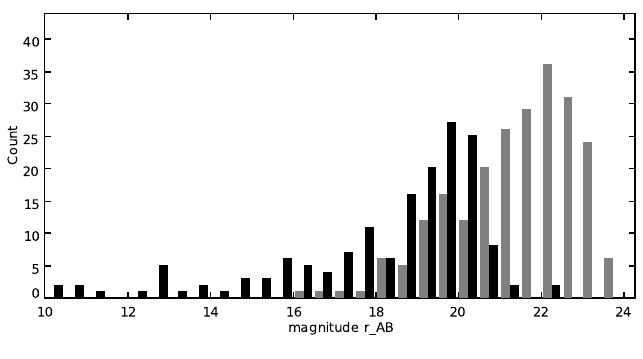
Fig. 1. The distribution of identified RCR sources with significant magnitude vari- ations (∆ m > 0 : 7 mag; black) and sources that have no such variations (grey). The comparison was carried out according to the USNO-B1, GSC 2.3 and SDSS DR7 data as well as to the 2MASS and UKIDSS LAS data. than ∆ m (cid:21) 0 : 7 mag in close optical or infrared bands according to